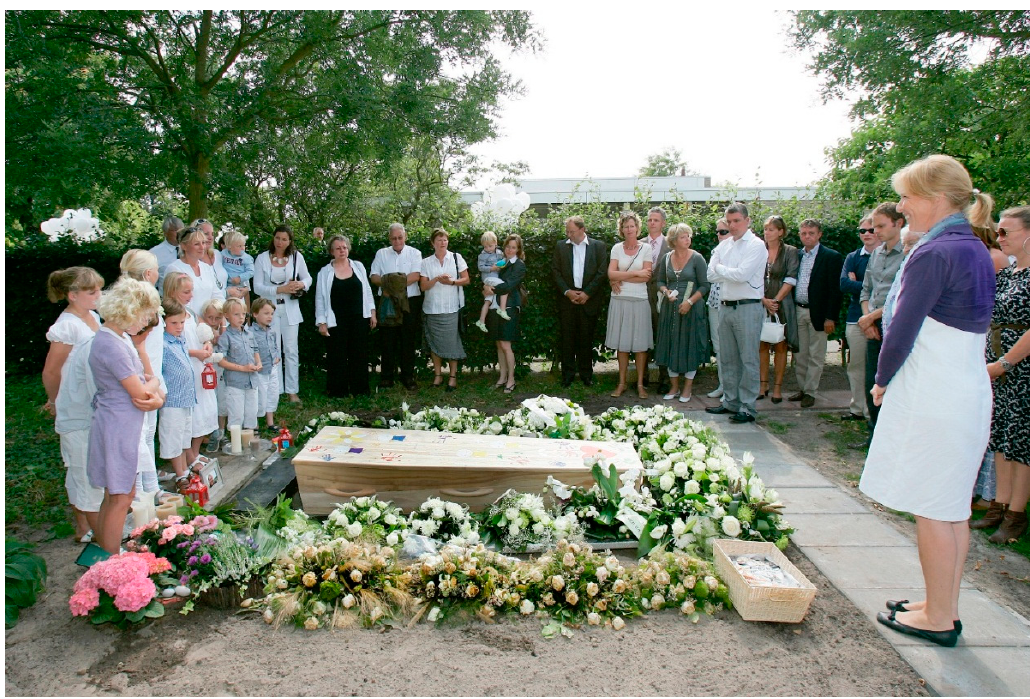
Photograph 4. At the graveyard. © Stilbeeld